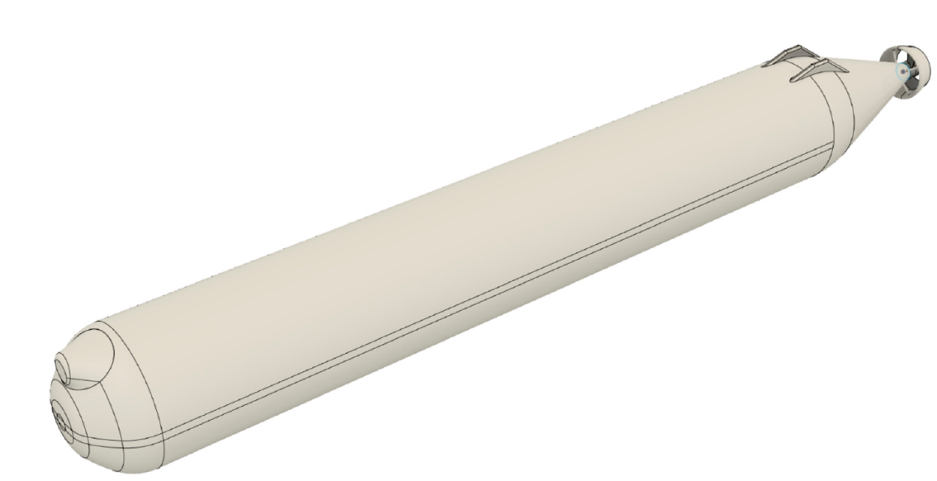
Figure 1. Equinor subsea shuttle tanker.